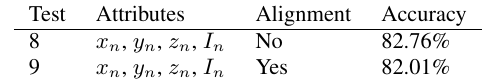
Table 2: Results obtained on the forest dataset. Only last returns were